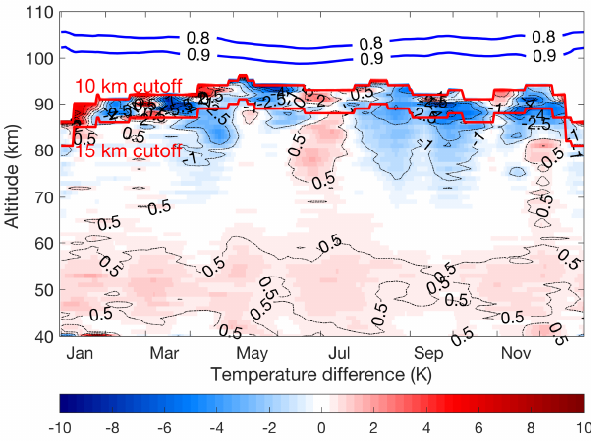
OEM and HC method (OEM minus HC) using seed pressure. The blue lines show the height below which the OEM temperature cli- matology is more than 90% (0.9) and 80% (0.8) due to the mea- surements. The red lines are the 10 and 15km cutoff height for the HC